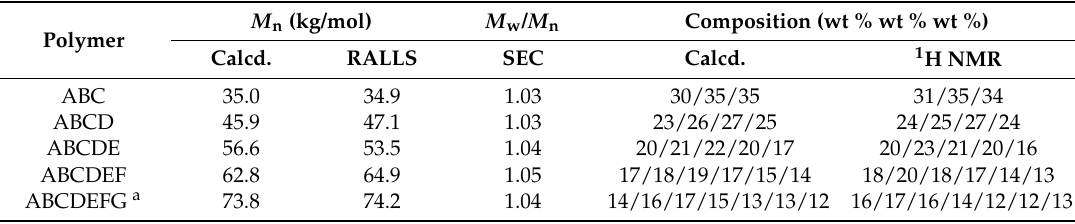
Table 3. Characterization results of ( µ -SP)s synthesized by the iterative methodology using X 1 , X 2 , and X 3